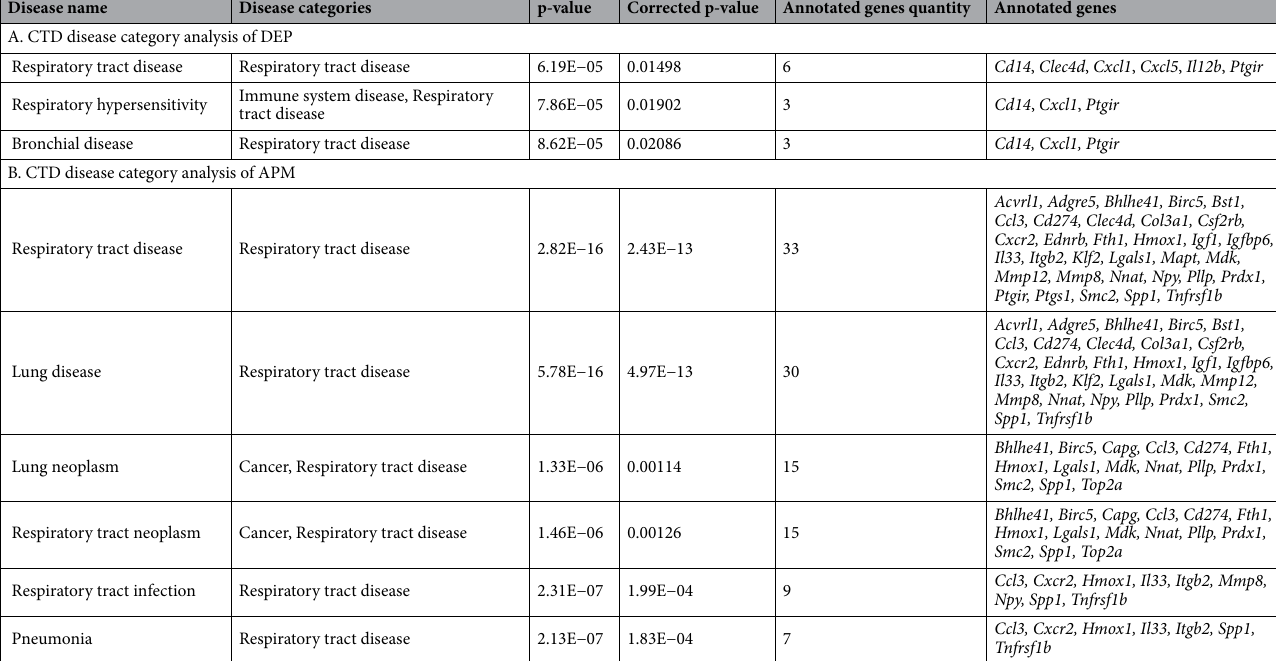
Table 3. CTD disease category analysis of DEP- or APM-altered genes. DEP diesel particulate matter, APM artificial particulate